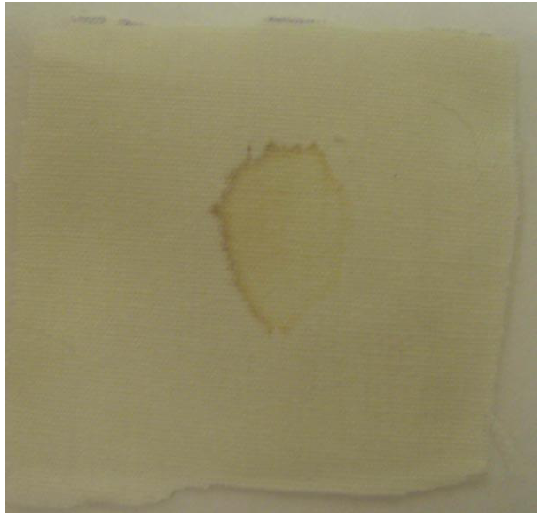
FIGURE 2. Bloodstain after